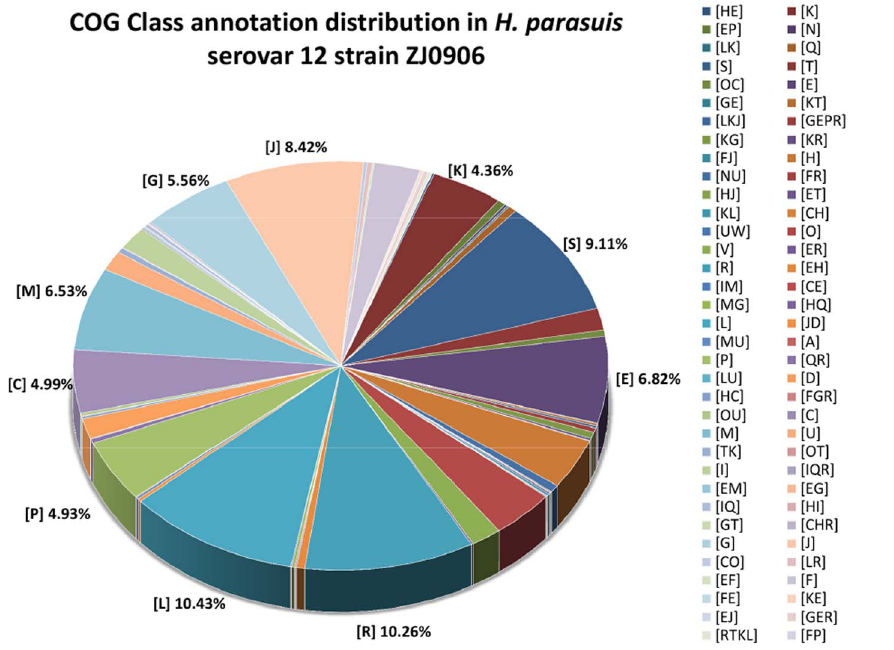
Figure 4. COG class distribution of H.parasuis ZJ0906 genome. The COG-annotated genes are grouped under their respective COG classes. Only their class abbreviations are used in this graph, their class descriptions are listed in Table 3. Percentages of the top ten classes are labeled for easy reference.